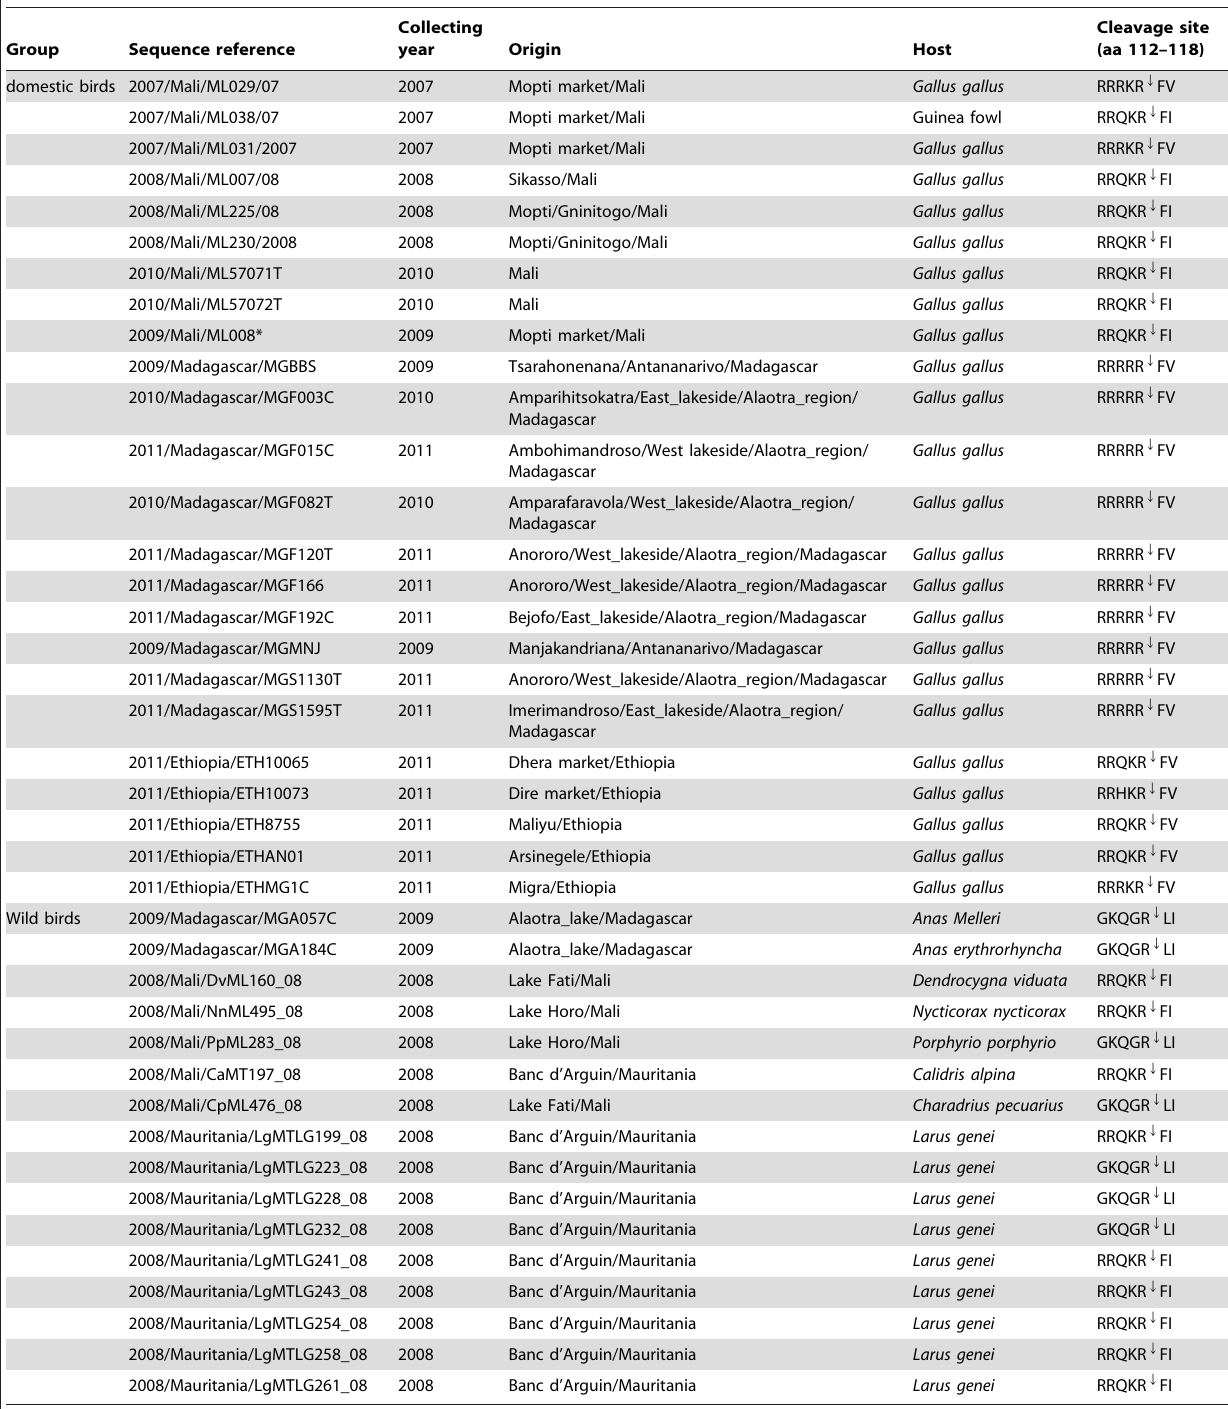
Table 2. Characteristics of viruses analyzed in this study.